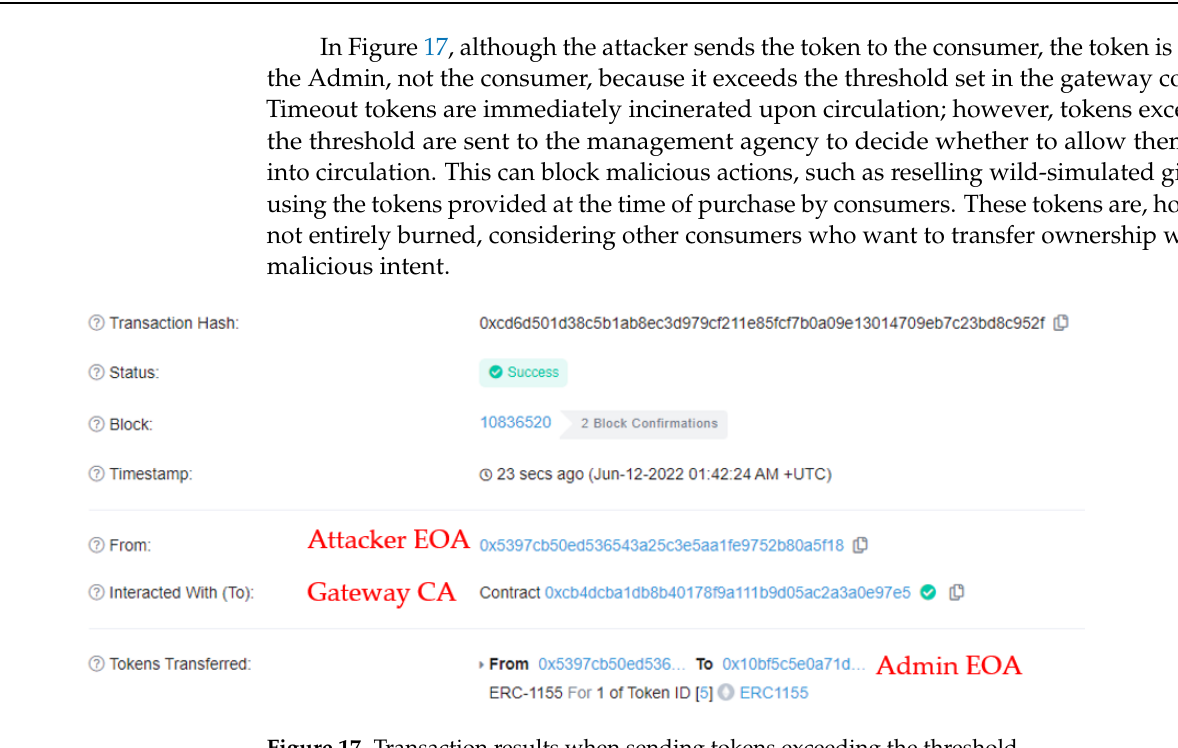
Figure 17. Transaction results when sending tokens exceeding the threshold.